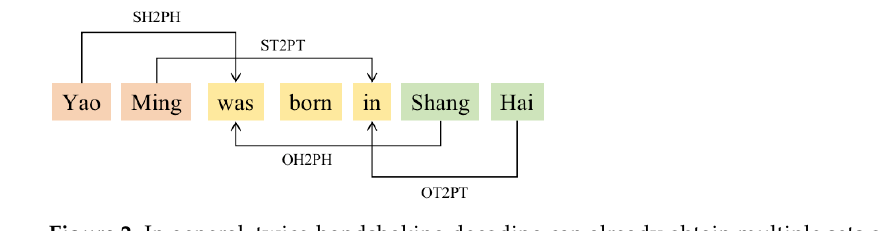
Figure 2. In general, twice-handshaking decoding can already obtain multiple sets of triples. Table 1. Labels of each position in sentence “Yao Ming was born in Shang Hai”. Row Char-Column